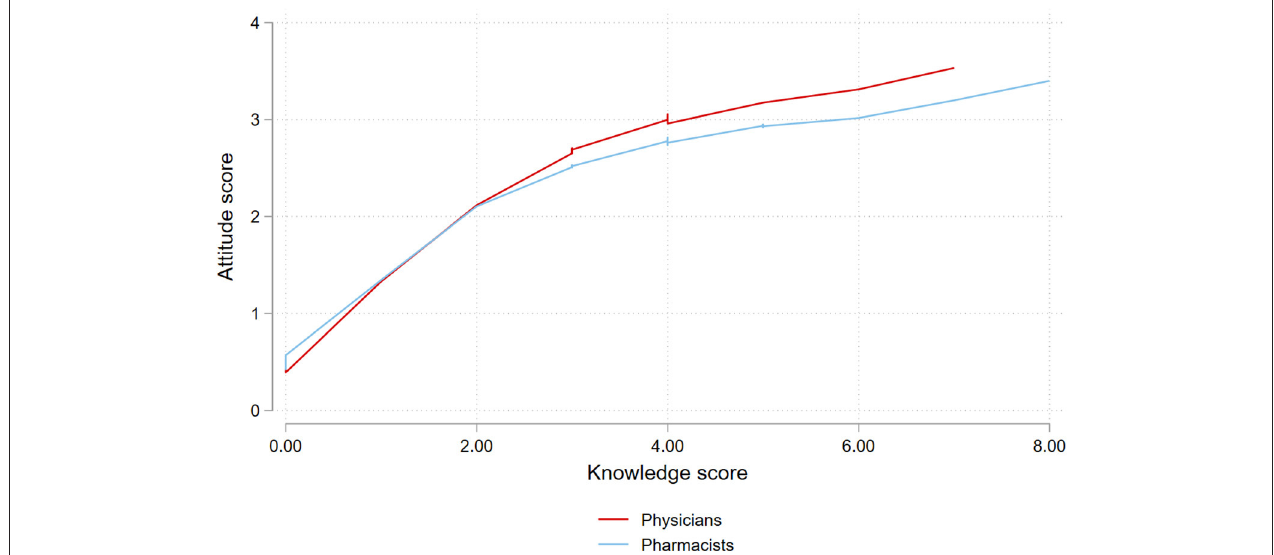
FIGURE 1 | Locally weighted scatterplot smoothing (LOWESS) of the attitude and knowledge